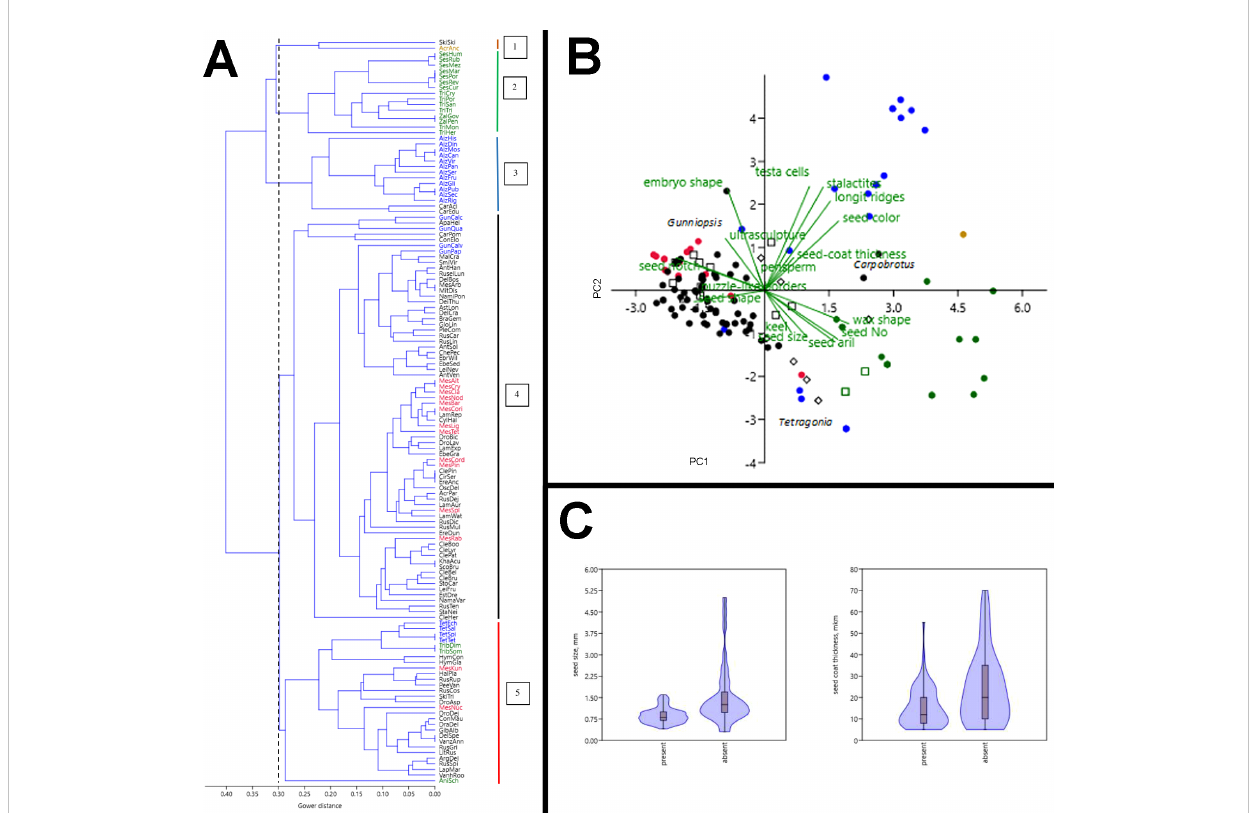
FIGURE 13 Multivariate analysis of the species examined. (A) Classi fi cation of Aizoaceae species by the paired linkage algorithm of cluster analysis based on 18 morphological characteristics. The dotted line indicates the highest level of group delimitation. Colored lines on the right mark subgroups (1 – 5) of species with common morphological seed and fruit characteristics. Name abbreviations are constructed from fi rst letters of generic and species names. Acrosanthoideae are highlighted in brown, Aizooideae in blue, Mesembryanthemoideae in red, Ruschioideae in black, and Sesuvioideae in green. (B) Ordination of species based on 18 morphological seed and fruit characteristics by principal component analysis. Brown dot: Acrosanthoideae, blue dots: Aizooideae, red dots: Mesembryanthemoideae, black dots: Ruschieae, black squares: Drosanthemeae, black diamonds: Apatesieae, green dots: Sesuvieae, and green squares: Anisostigmateae. PC 1: fi rst principal component (describes 26.1% of total variance of morphological characteristics of seeds and fruits), PC2: second principal component (13.8%). Genera with a position highly deviating from other representatives of their families are marked as follows: Tetragonia (blue dots), Gunniopsis (blue dots), and Carpobrotus (black dots). (C) Differences in seed size (left) and seed-coat thickness (right) between species with hygrochasy (present) and without hygrochasy (absent). Differences in both cases are signi fi cant according to the Mann – Whitney test (P <